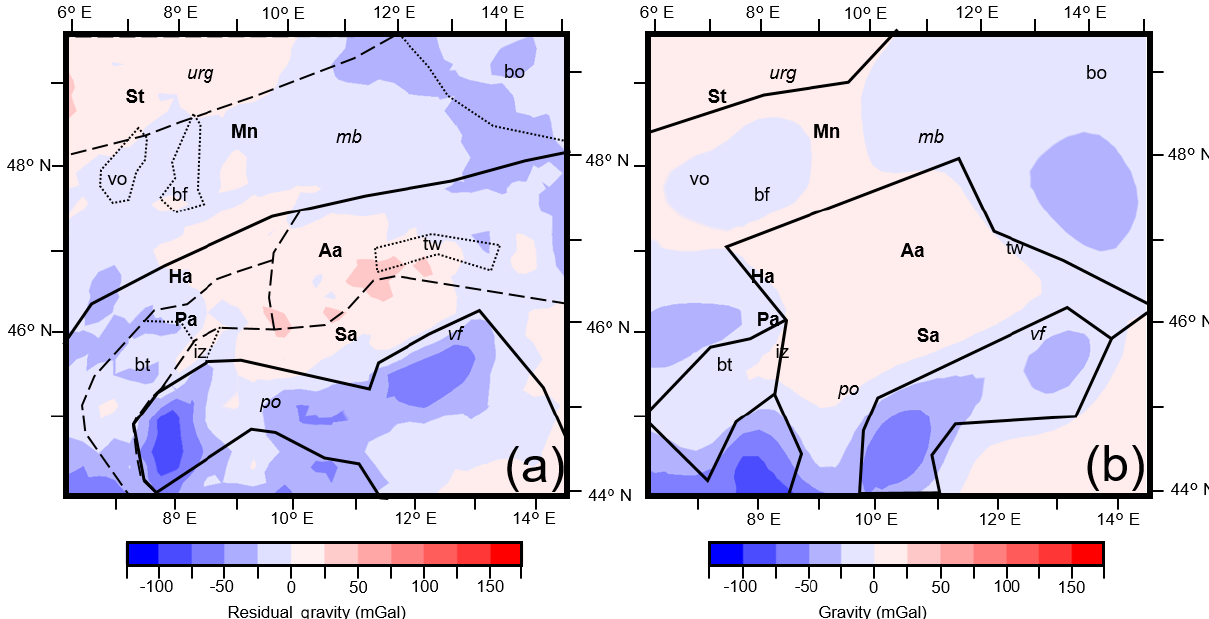
Figure 9. (a) Residual gravity (observed gravity–calculated gravity) of a test model with lower-crust densities for the Europe and north Adria domains set to values indicated directly from P wave velocities using conversion suggested by Brocher (2005). (b) Difference in gravity residual between the best-fit model (Fig. 6b) and the model shown in Fig. 9a. Lower-crustal density domains of the best-fit model are overlaid in